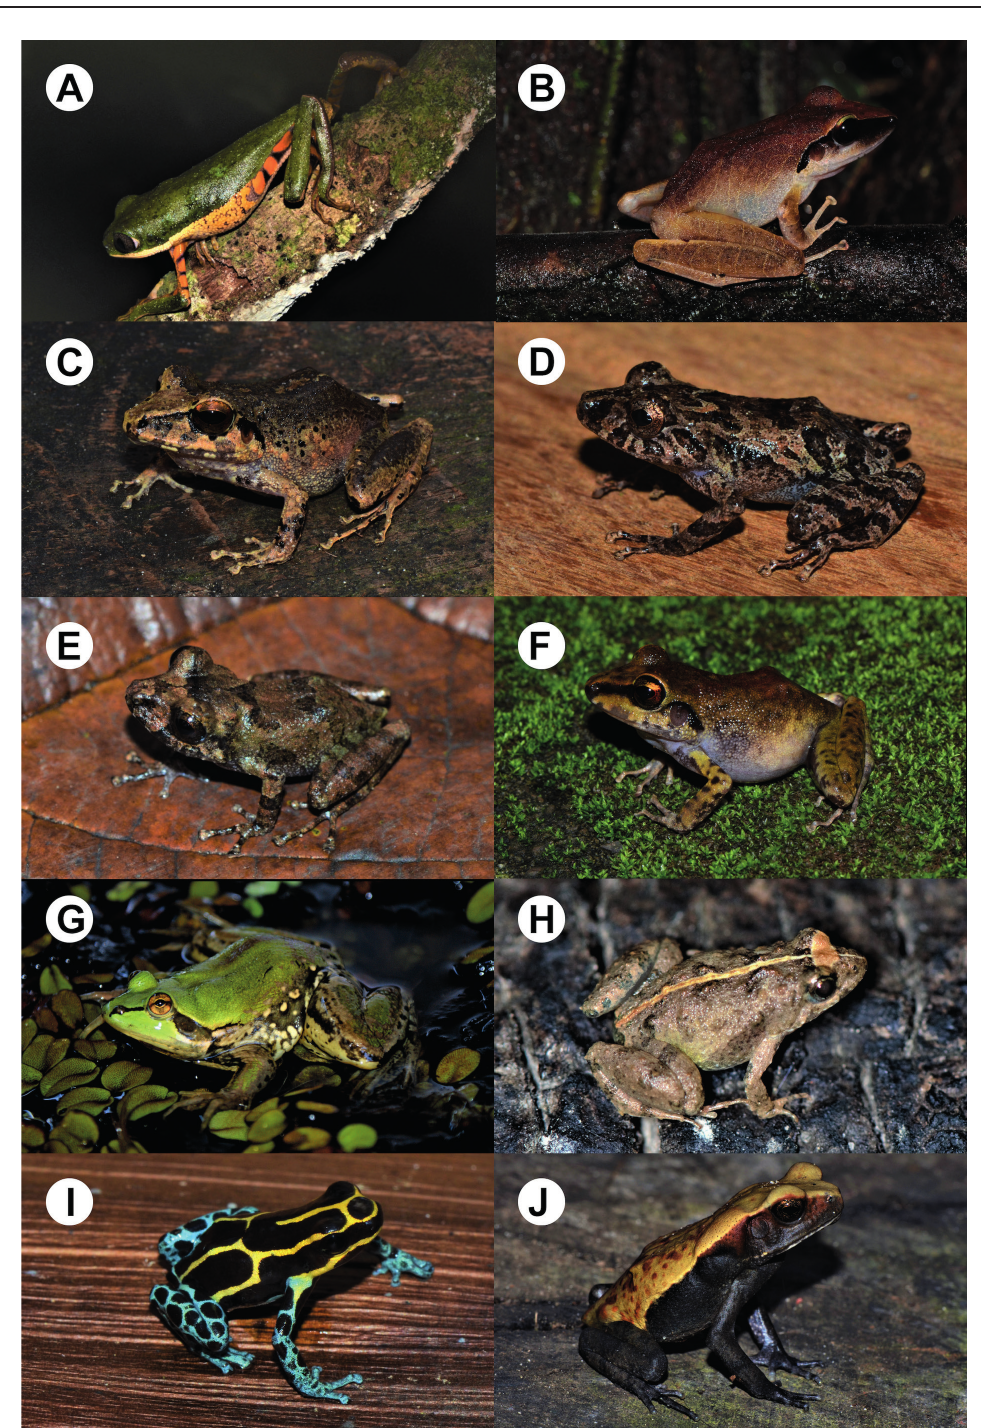
Fig. 7. Anuran species recorded in the state of Amapá. A . Pithecopus hypochondrialis (Daudin, 1800). B . Pristimantis chiastonotus (Lynch & Hoogmoed, 1977). C . Pristimantis gutturalis (Hoogmoed, Lynch & Lescure, 1977). D . Pristimantis inguinalis (Parker, 1940). E . Pristimantis crepitaculus Fouquet, Peloso, Jairam, Lima, Mônico, Ernst & Kok, 2022. F . Pristimantis zeuctotylus (Lynch & Hoogmoed, 1977). G . Pseudis paradoxa (Linnaeus, 1758). H . Pseudopaludicola boliviana Parker, 1927. I . Ranitomeya variabilis Zimmermann & Zimmermann, 1988. J . Rhaebo guttatus (Schneider, 1799) . Photos: C.E.